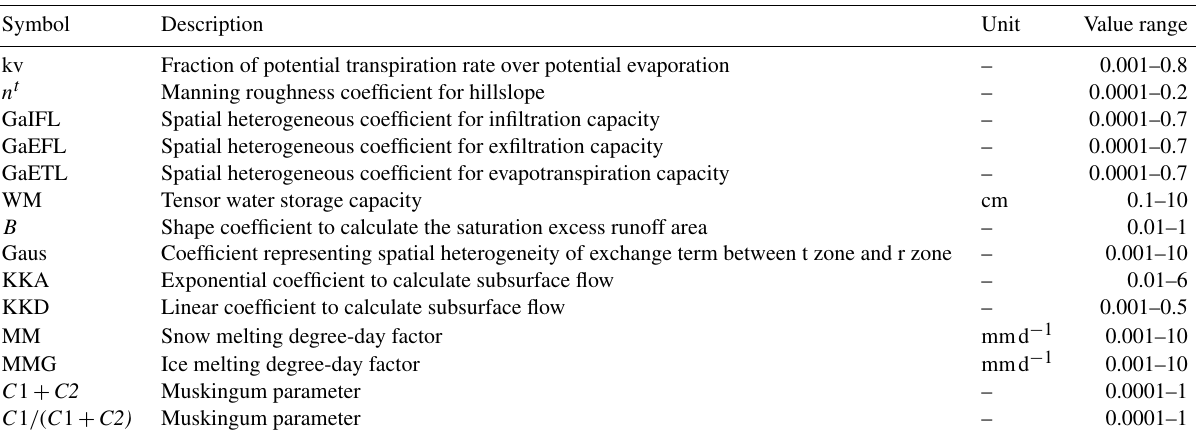
Table 4. Calibrated parameters of the THREW